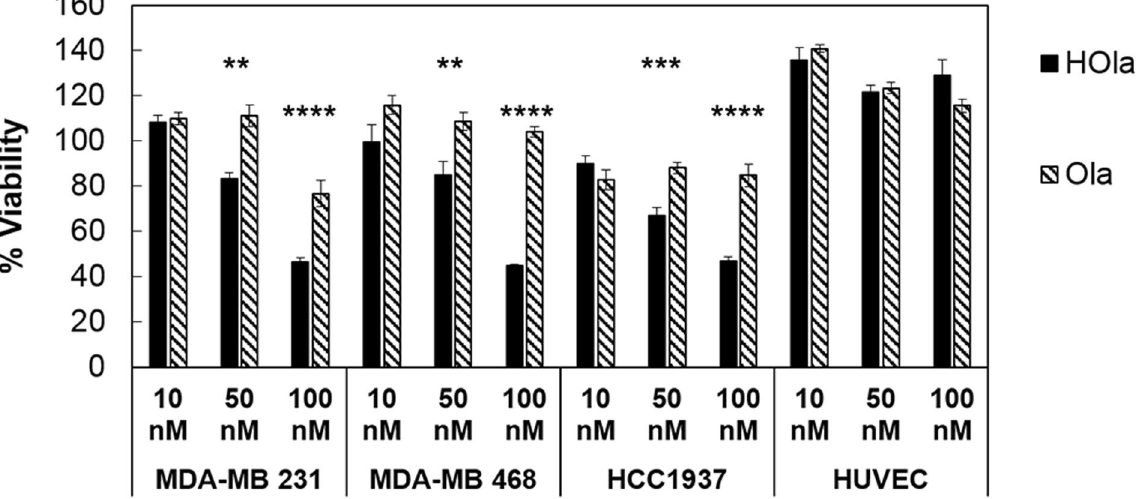
Figure 4. Viability of TNBC cells treated with Ola or HOla nanoparticles. HCC1937, MDA-MB 231, MDA-MB 468 and HUVEC cells were treated with 10, 50 and 100 nM Ola or HOla for 72 h. Viability was assessed by measuring the conversion of MTS into formazan. Reported values are the mean of six replicates ± s.e., normalized on cell proliferation of untreated cells, respectively. Statistical significance of HOla vs . free drug, ** P < 0.005; *** P < 0.0005; **** P < 0.0001 (Student’s t